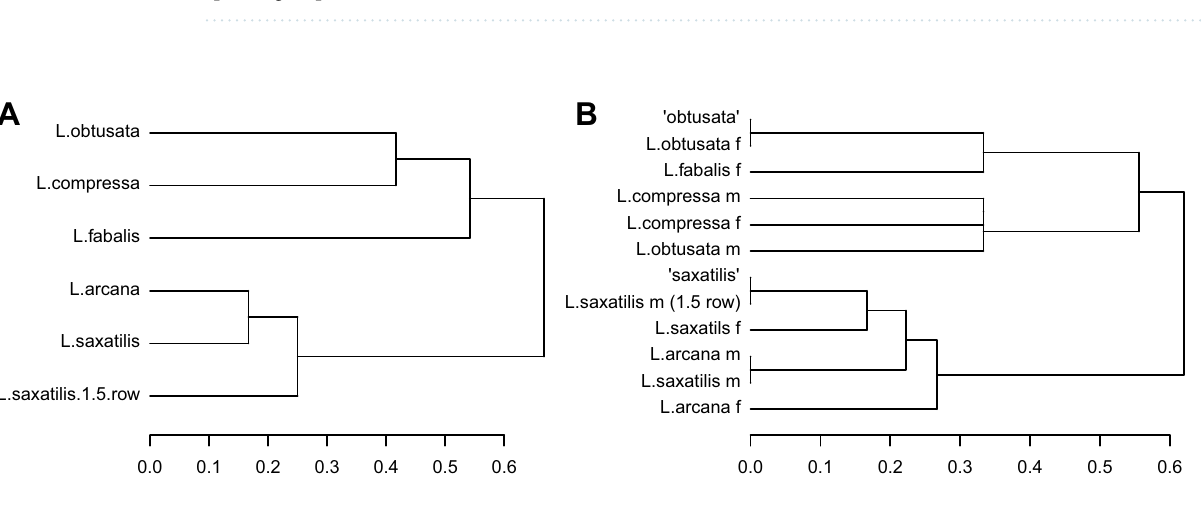
Table 3. Observed combinations of partner types in mating pairs. The category L. saxatilis (1.5 row) includes male L. saxatilis with 1.5 rows of penial glands (presumably hybrids of L. saxatilis and L. arcana ). The categories “obtusata” and “saxatilis” include immature or castrated individuals of the corresponding cryptic species group.